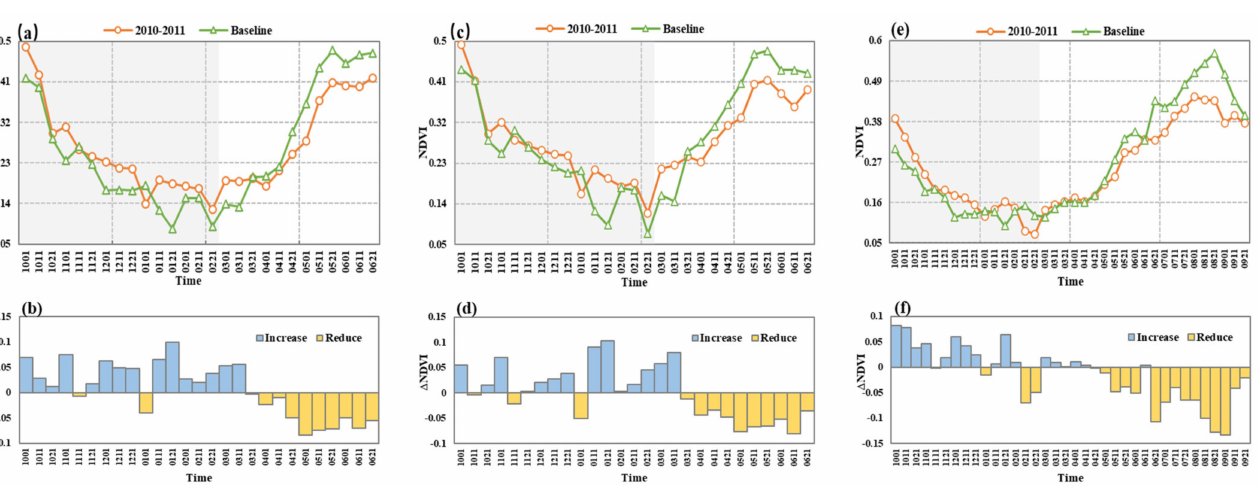
Figure 5. Temporal variation of NDVI in different vegetation types. ( a , b ) grassland, ( c , d ) cultivated land, ( e , f ) forest. ( a , c , e ) Variation of NDVI in 2010–2011 compared to baseline and ( b , d , f ) anomalies of NDVI in 2010–2011 relative to baseline. Time is expressed as month day (i.e., 1001 − 1 October 2010; 0621–21 June 2011). Shading area indicates the period of drought. Baseline condition is represented by the NDVI of 2011 −